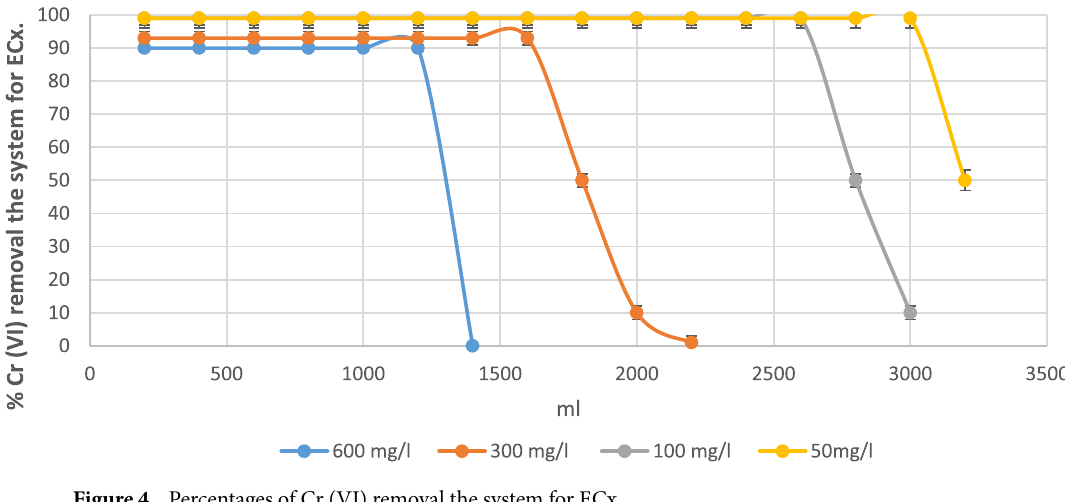
Figure 4. Percentages of Cr (VI) removal the system for ECx.